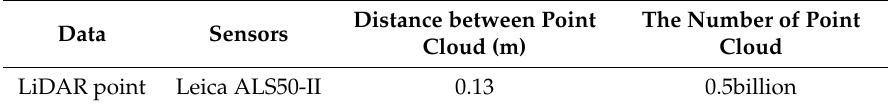
Table 2. Detail information of vehicle-borne LiDAR.